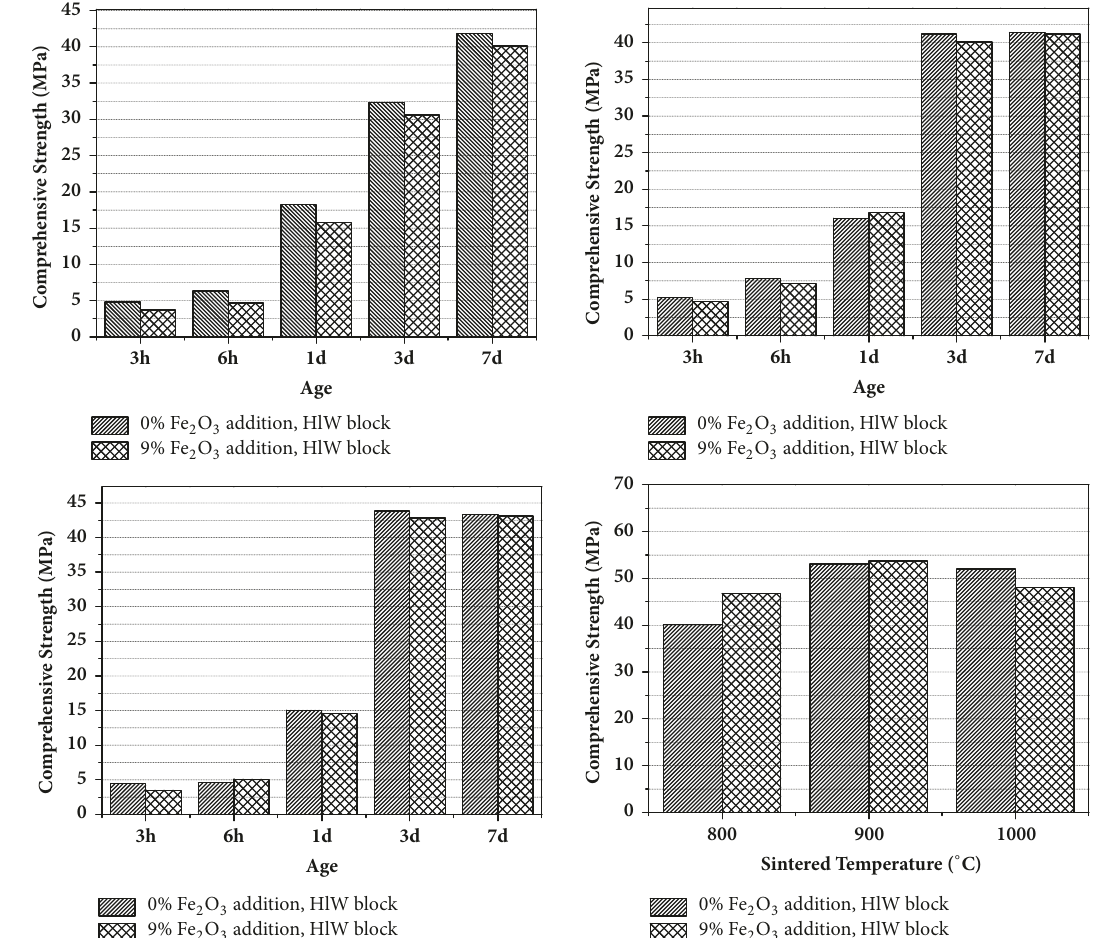
Figure 3: Comprehensive strength of solidification forms. A HLW pH=3, B HLW pH=5, C HLW pH=7, D HLW pH=5, sintered samples.